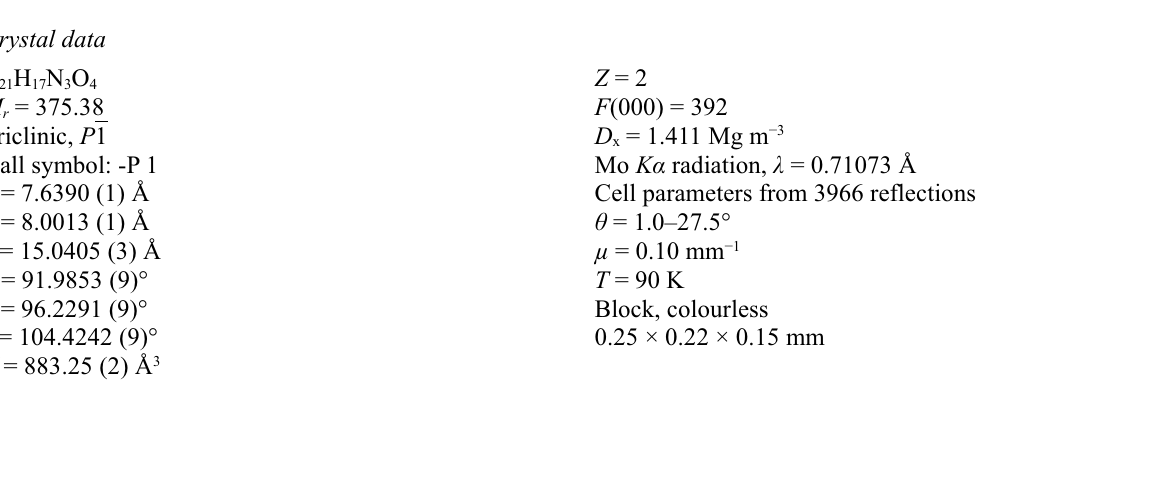
A view of the molecule with the atom numbering scheme. Displacement ellipsoids are drawn at the 50% probability level. ( Z )-Methyl 4-({3-[(2,5-dioxoimidazolidin-4-ylidene)methyl]-1 H -